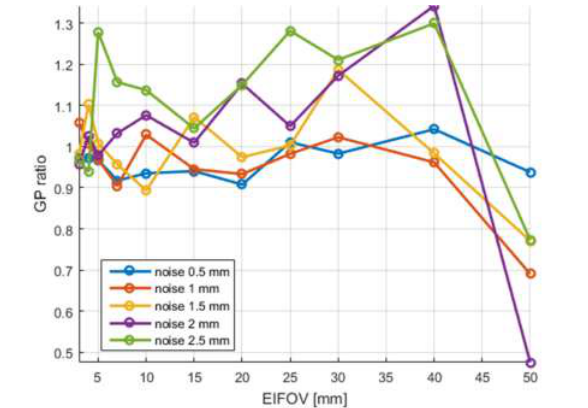
Figure 9. GP ratio of DWT denoised surfaces versus